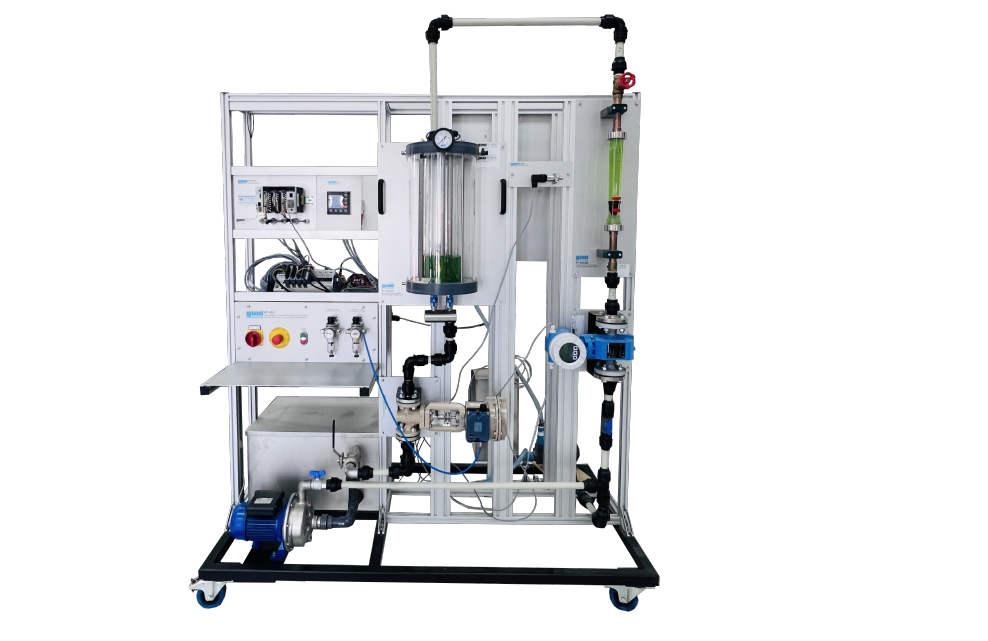
Figure 18. GÜNT RT450.01 level tank